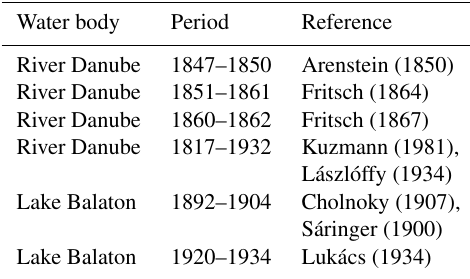
Table 1. Additional data sources concerning the ice regime of the River Danube and Lake